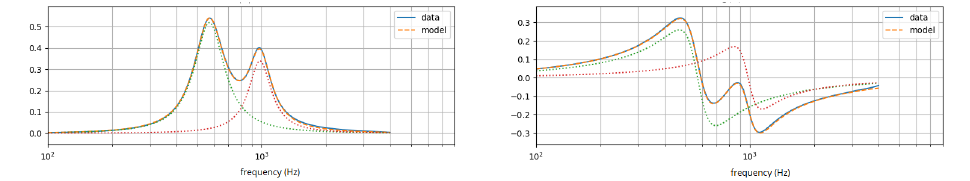
Figure 17. Real ( left ) and imaginary ( right ) parts of complex specific admittances from data for MPP material (solid line) along with fitted filter model (dashed line) used in the FDTD simulation. Dotted lines show underlying resonances in the filter